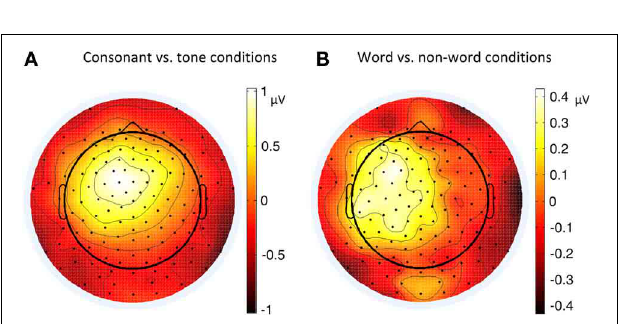
FIGURE 4 | Topographies of P2 (180–200ms) contrasts in different conditions of Experiment 1. (A) Consonant vs. tone condition; (B) Word vs. non-word condition.